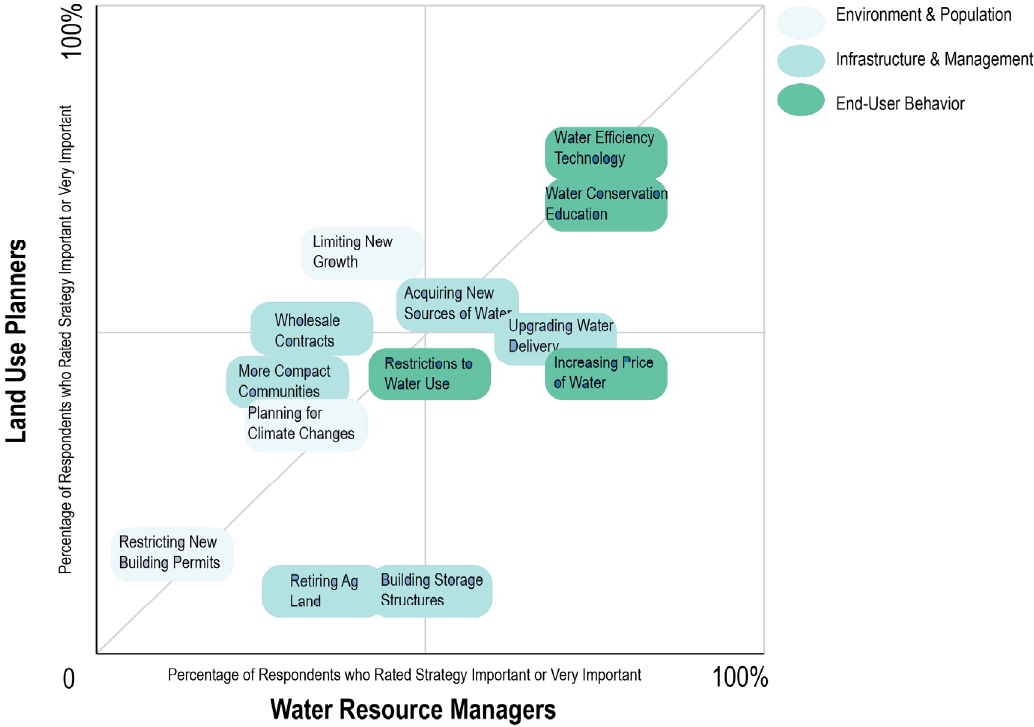
Figure 3. Water Resource Strategies rated at least 7/10 on a scale of importance, by profession.